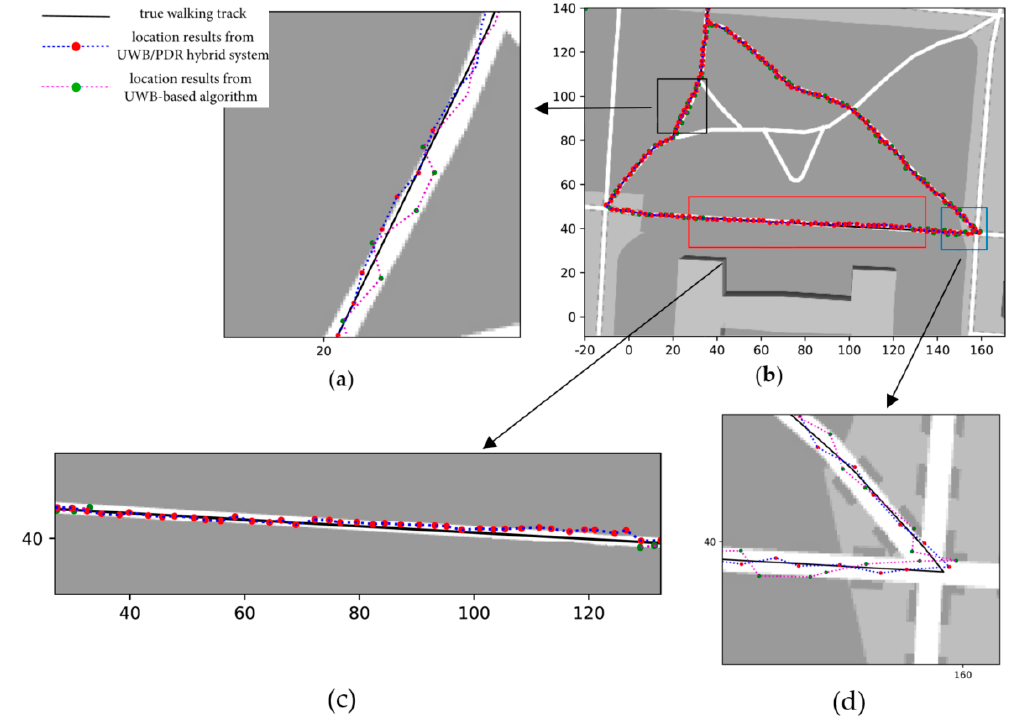
Figure 11. Comparison of experimental results from different localization algorithms: ( a ) Zoomed-in on the black frame in Figure b; ( b ) a comparison of the two localization results: UWB and hybrid system; ( c ) zoomed-in on the red frame in Figure b; ( d ) zoomed-in on the blue frame in Figure b.